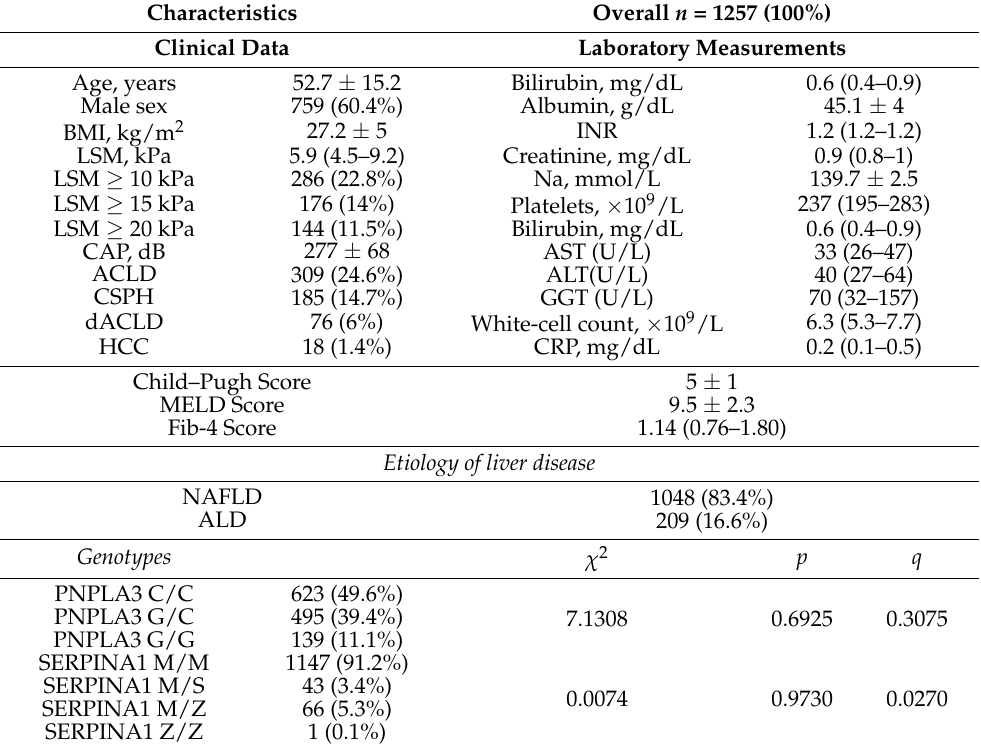
Table 1. Clinical and laboratory characterizations of the overall cohort ( n =